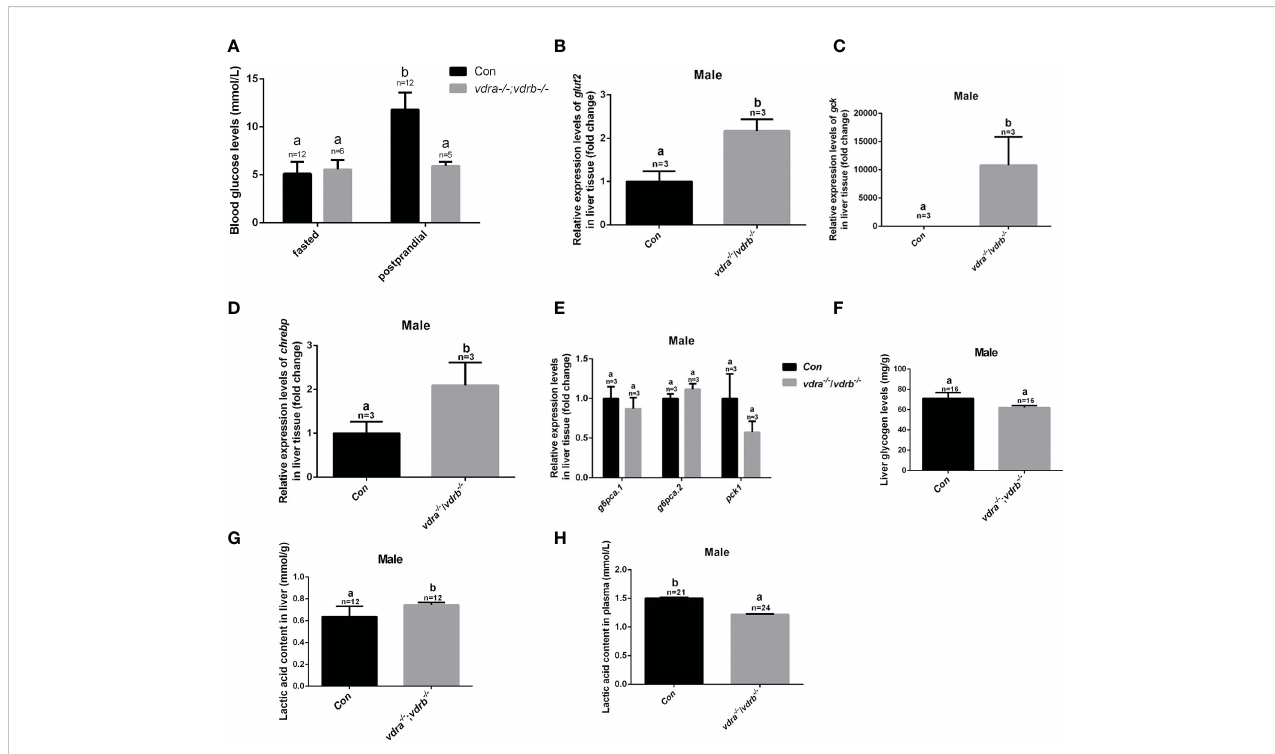
FIGURE 5 Glucose metabolic homeostasis was impaired in the liver of vdra -/- ; vdrb -/- zebra fi sh. (A) Blood glucose levels of vdra -/- ;vdrb -/- fi sh and control siblings in the fasted state and postprandial state at 100 dpf. (B – D) . Quantitative real-time PCR showed glut2, gck and chrebp transcriptional levels in the liver of mutants and control siblings at 100 dpf; (E) Quantitative real-time PCR showed gluconeogenesis marker gene g6pca.1, g6pca.2 and pck1 transcriptional levels in the liver of the vdra -/- ; vdrb -/- fi sh and control siblings at 100dpf. (F) The liver glycogen levels in vdra -/- ; vdrb -/- fi sh and control siblings at 100 dpf. (G, H) . The liver lactic acid levels in vdra -/- ; vdrb -/- fi sh and control siblings at 100 dpf. The bars with different letters indicated signi fi cant difference (p<0.05).